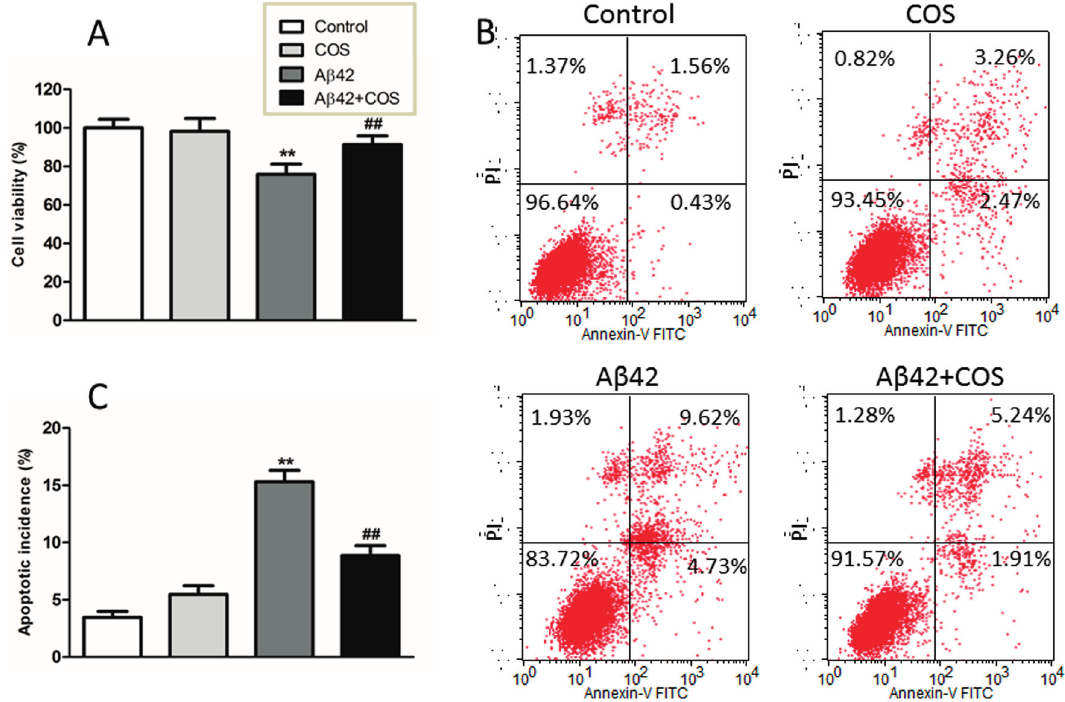
Figure 4. Effect of COS on A β 42-induced neurotoxicity in cortical neurons. ( A ) Neurons were treated with 5 μ M A β 42 with or without addition of 0.5 mg/mL COS for 48 h, the cell viability was determined by the MTT assay; ( B ) Representative graphs obtained by flow cytometry using double staining with Annexin V-FITC and PI; ( C ) The apoptotic incidence of rat cortical neurons exposed to 5 μ M A β 42 in the presence or absence of 0.5 mg/mL COS for 48 h. Results were expressed as the percentage of apoptotic cells that include neurons in early and late apoptotic phases. Data were expressed as means ± SEM of three independent experiments. ** p < 0.01 vs. Control, ## p < 0.01 vs. A β 42